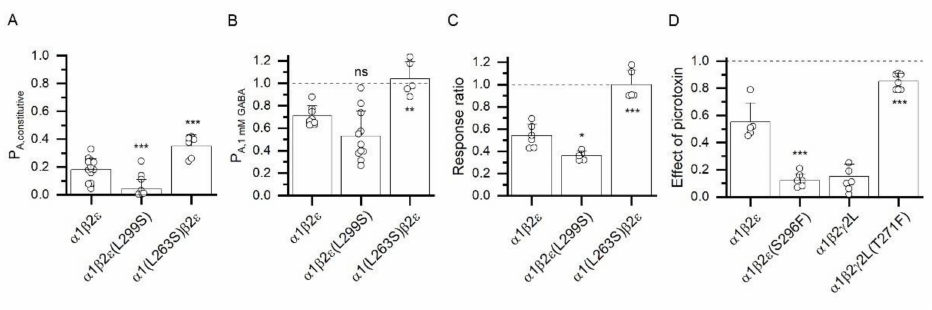
Figure 4. Divergent consequences of homologous mutations in the TM2 regions of ε sub- units and α 1 or γ 2L subunits. ( A ) P A,constitutive in α 1 β 2 ε , α 1 β 2 ε (L299S), and α 1(L263S) β 2 ε re- ceptors. ( B ) P A,1 mM GABA in α 1 β 2 ε , α 1 β 2 ε (L299S), and α 1(L263S) β 2 ε receptors. ( C )